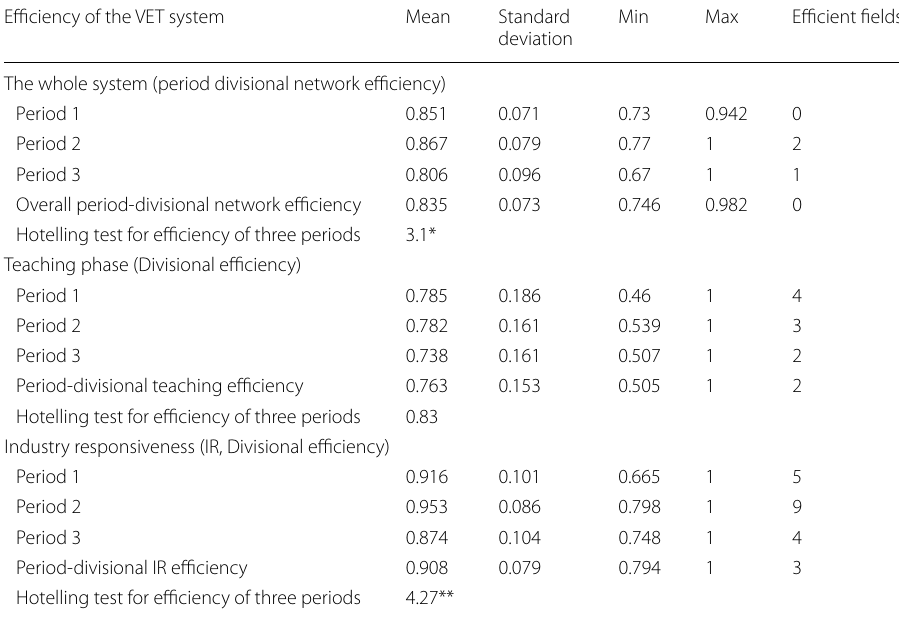
** and * denote the significance levels at 5% and 10%,